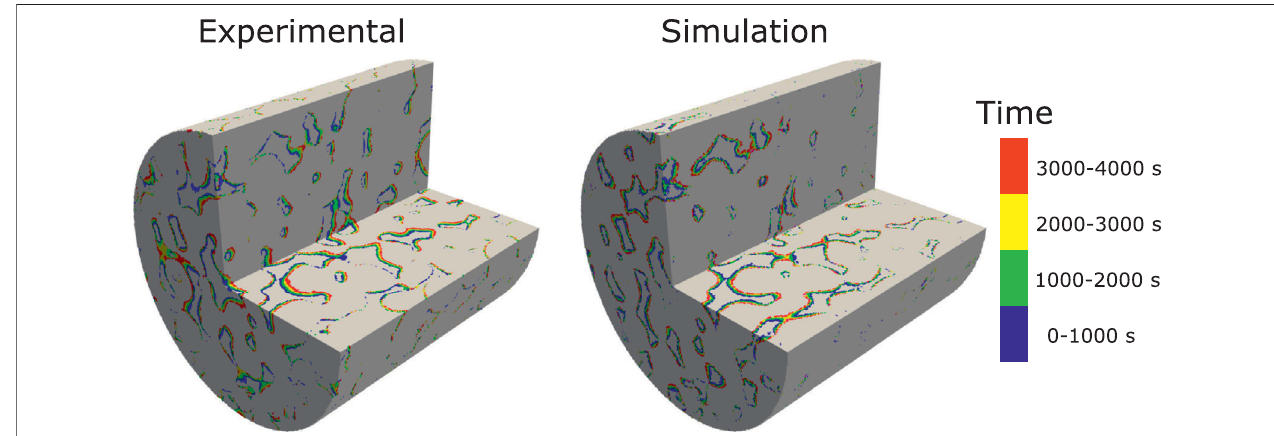
FIGURE9| Experimental and simulatedresultsshowingtheevolutionofthedissolutionpattern ina3Dmicro-CTimage ofKettonCarbonate. Thecolorsrepresent different time intervals.